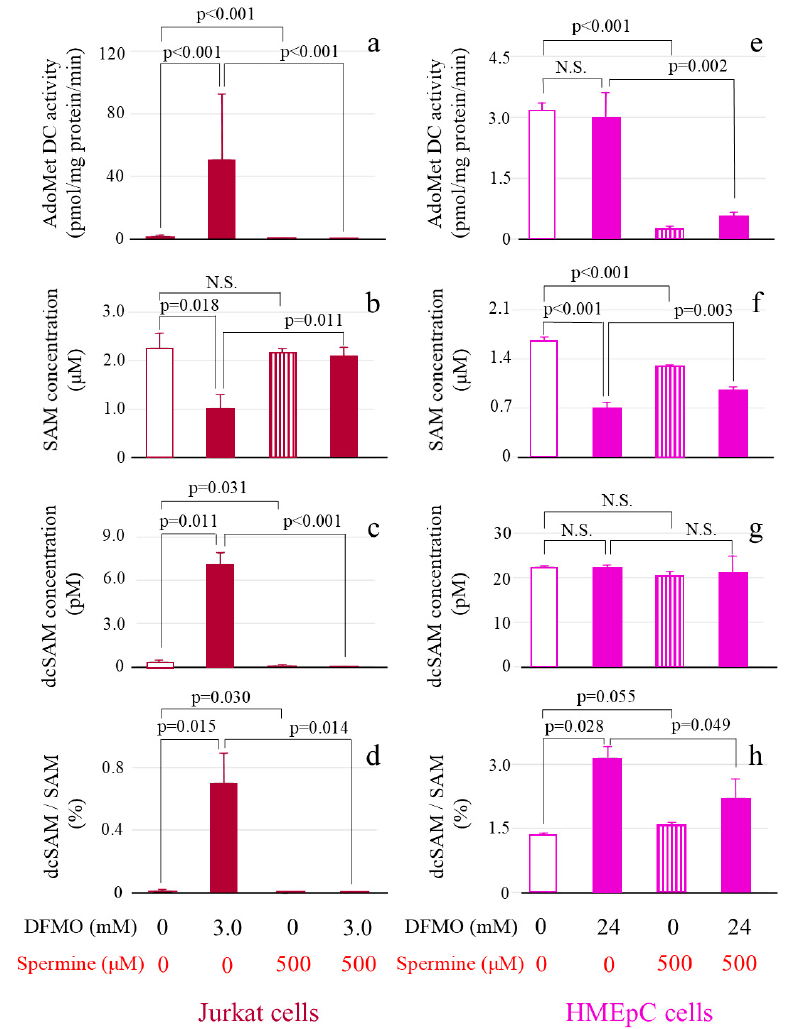
Figure 4. The effect of DFMO and spermine on AdoMetDC activity, SAM concentration, dcSAM concentration, and dcSAM/SAM ratio. AdoMetDC activity: Cells cultured for 72 h in different conditions were collected and the 14 CO 2 released when 14 C-labeled adenosyl-L-methionine (carboxyl- 14 C) was converted to dcSAM by AdoMetDC was measured using a scintillation counter. SAM and dcSAM concentrations in Jurkat cells (1.0 × 10 6 ) and HMEpCs (1.0 × 10 5 ) were measured by HPLC. ( a ): AdoMetDC activity (pmol/mg protein/min) in Jurkat cells. ( b ): SAM concentration ( µ M) in Jurkat cells. ( c ): dcSAM concentration (pM) in Jurkat cells. ( d ): dcSAM/SAM ratio (%) in Jurkat cells. ( e ): AdoMetDC activity (pmol/mg protein/min) in HMEpCs.( f ): SAM concentration ( µ M) in HMEpCs. ( g ): dcSAM concentration (pM) in HMEpCs. ( h ): dcSAM/SAM ratio (%) in HMEpCs. Data are shown as means and standard deviations of six samples ( n = 6) for each culture condition. N.S.: not